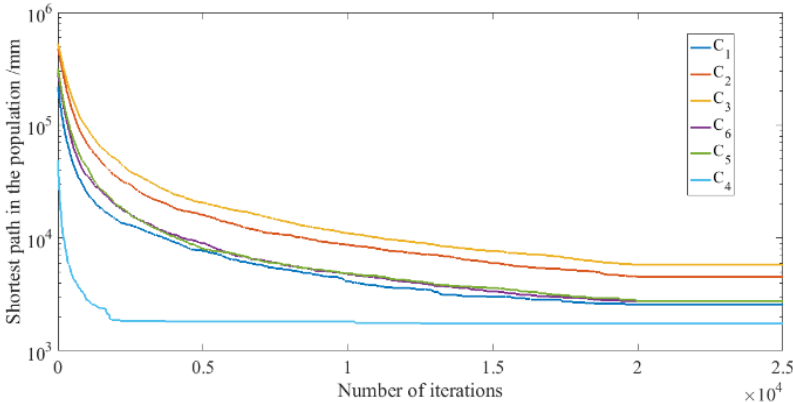
Figure 31. The iterative process of the genetic algorithm.